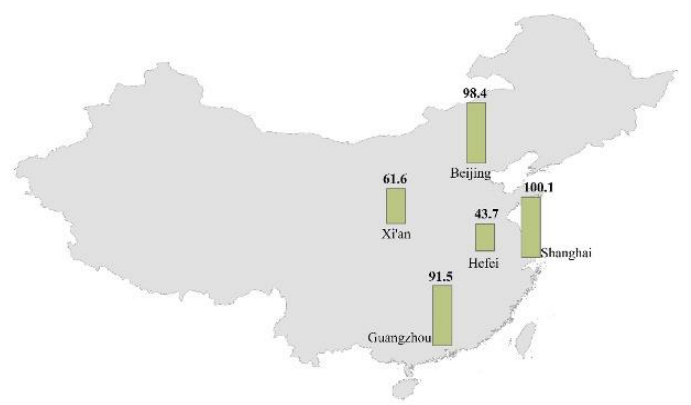
Figure 1. Map showing the locations of five studied cities and two-year averaged MDA8 ozone concentrations (µg m −3 ) during 2014–2015.